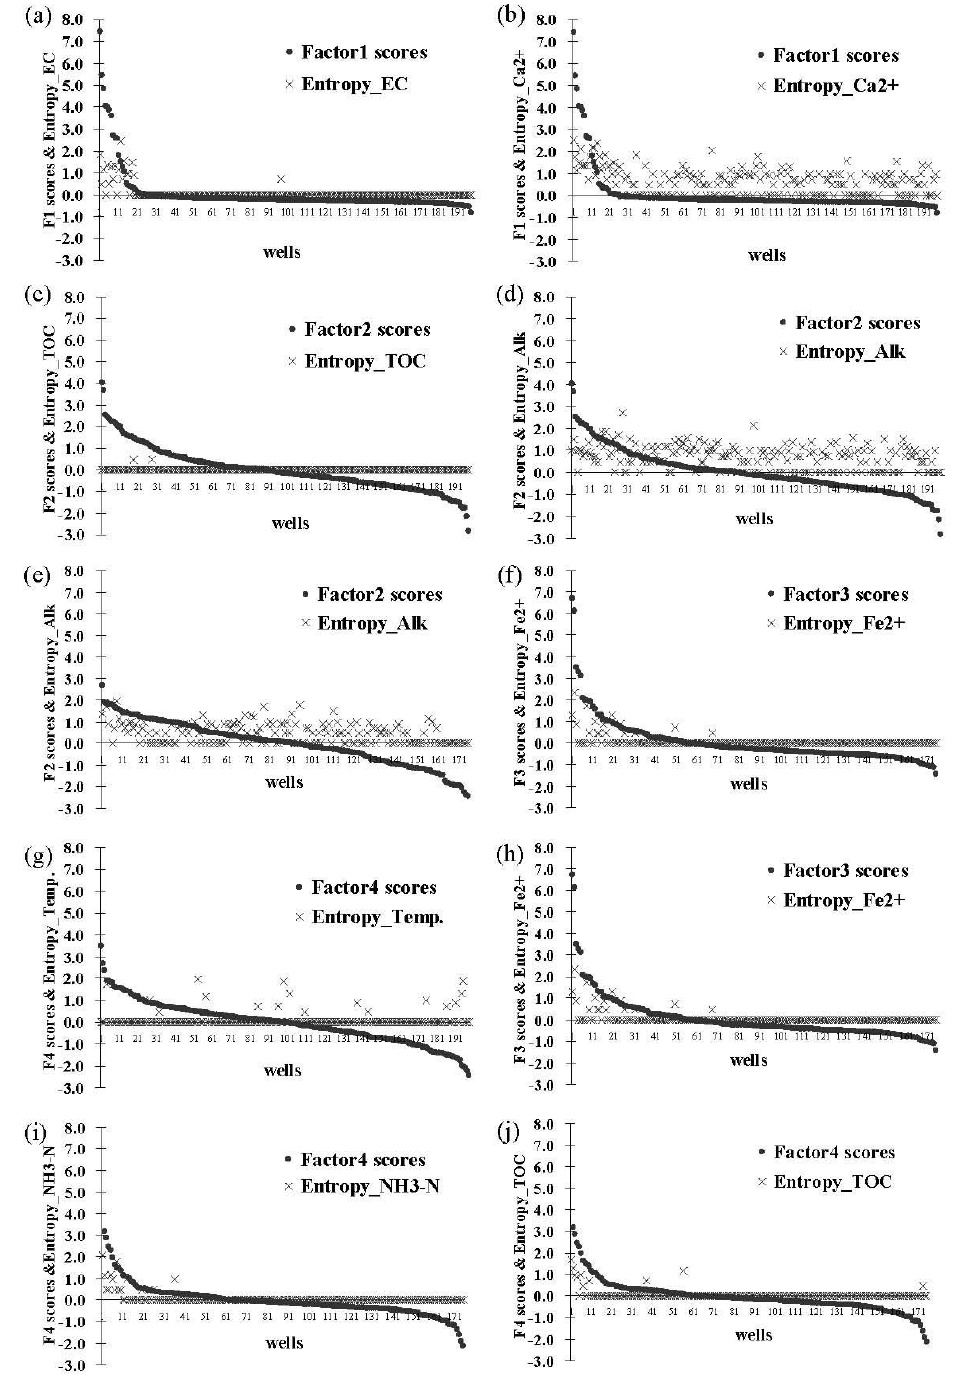
Figure 6. Relations between the factor score and information entropy value (a)